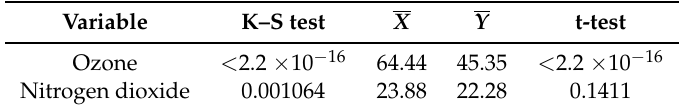
Table 1. p -values obtained in the two sample Kolmogorov–Smirnov (K–S) test of equality of distributions and in the two sample Student’s t -test of equality of means.